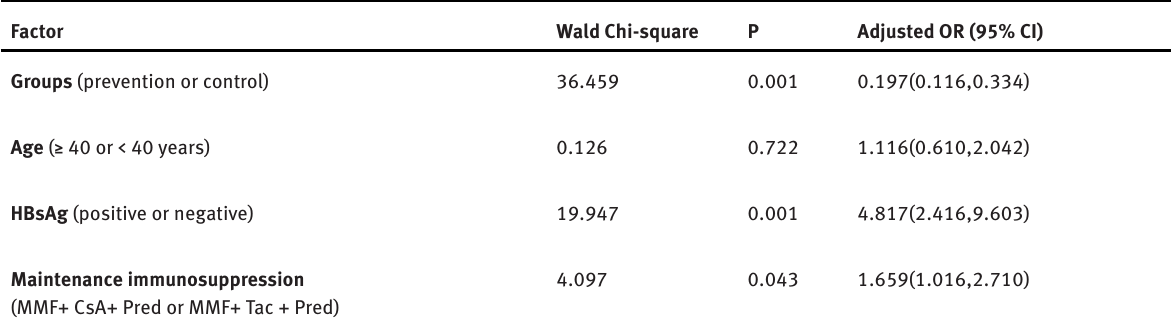
Table 3: Multifactorial analysis of the occurrence of liver injuries